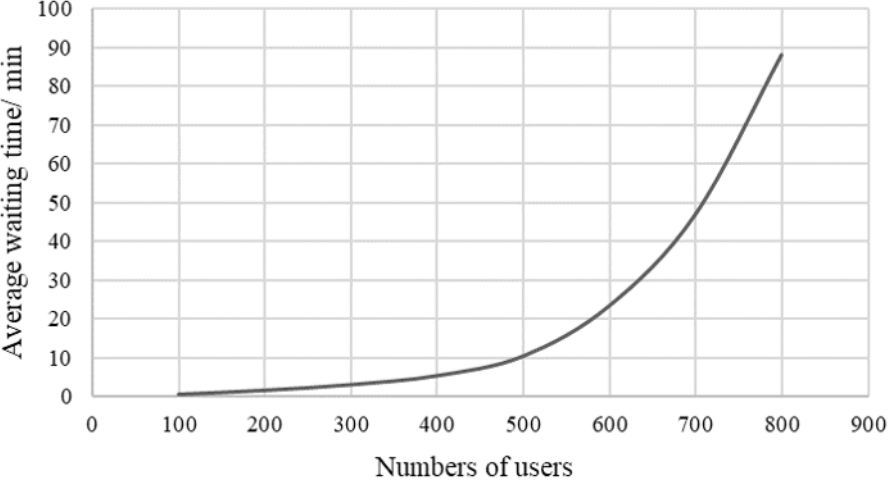
Figure 9. Correlations of the average waiting time with the number of users.